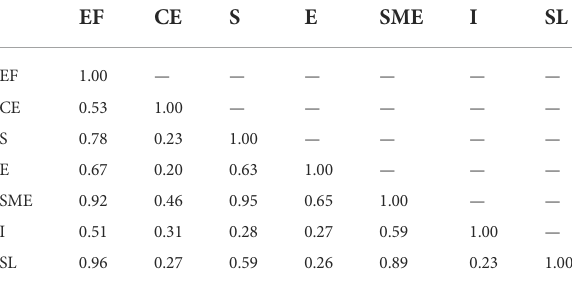
TABLE 6 Co-occurrences of SPP main